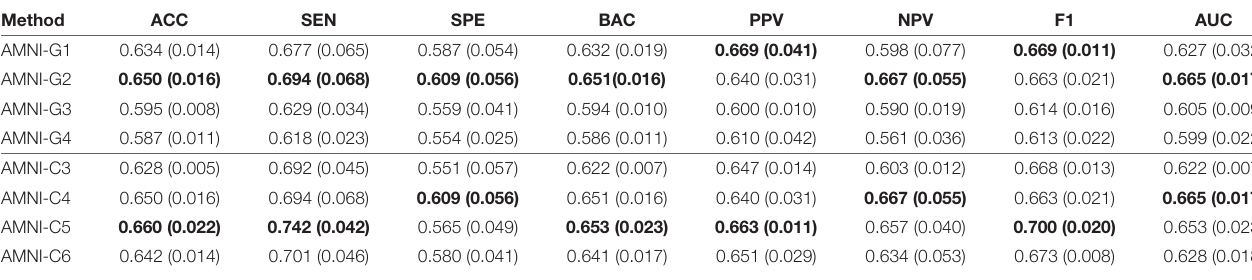
TABLE 5 | Classification results of our AMNI in MDD vs. HC classification with different network depth, with best results shown in bold. Method